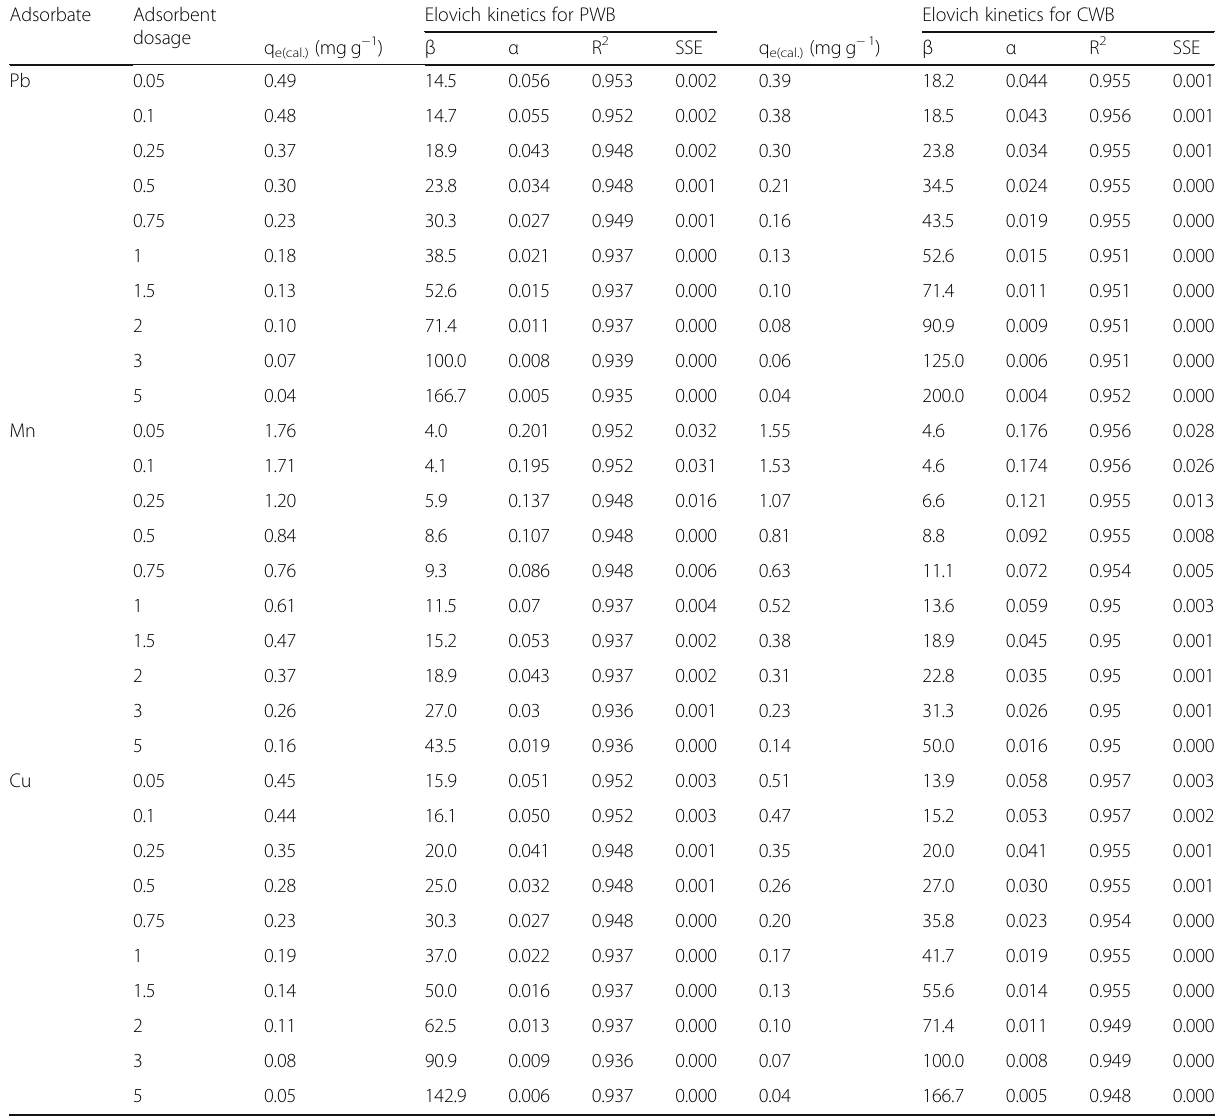
Table 2 Kinetic parameters of the Elovich model for adsorption of heavy metals onto BC in landfill leachate Adsorbate Adsorbent